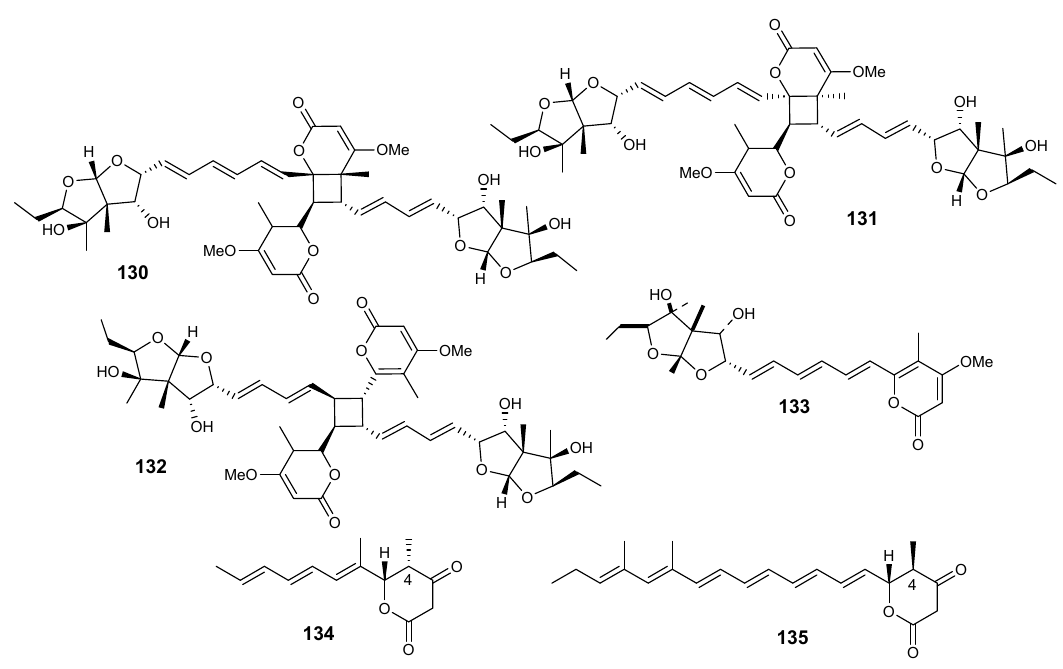
Figure 9. Structures of compounds 130–135.